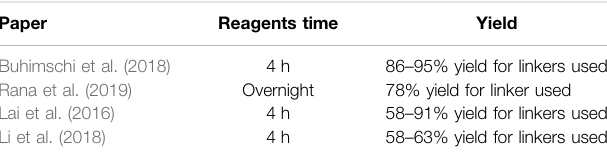
TABLE 2 | Reaction times and yields for the conversion of compound 17 to 28 ( Scheme 6